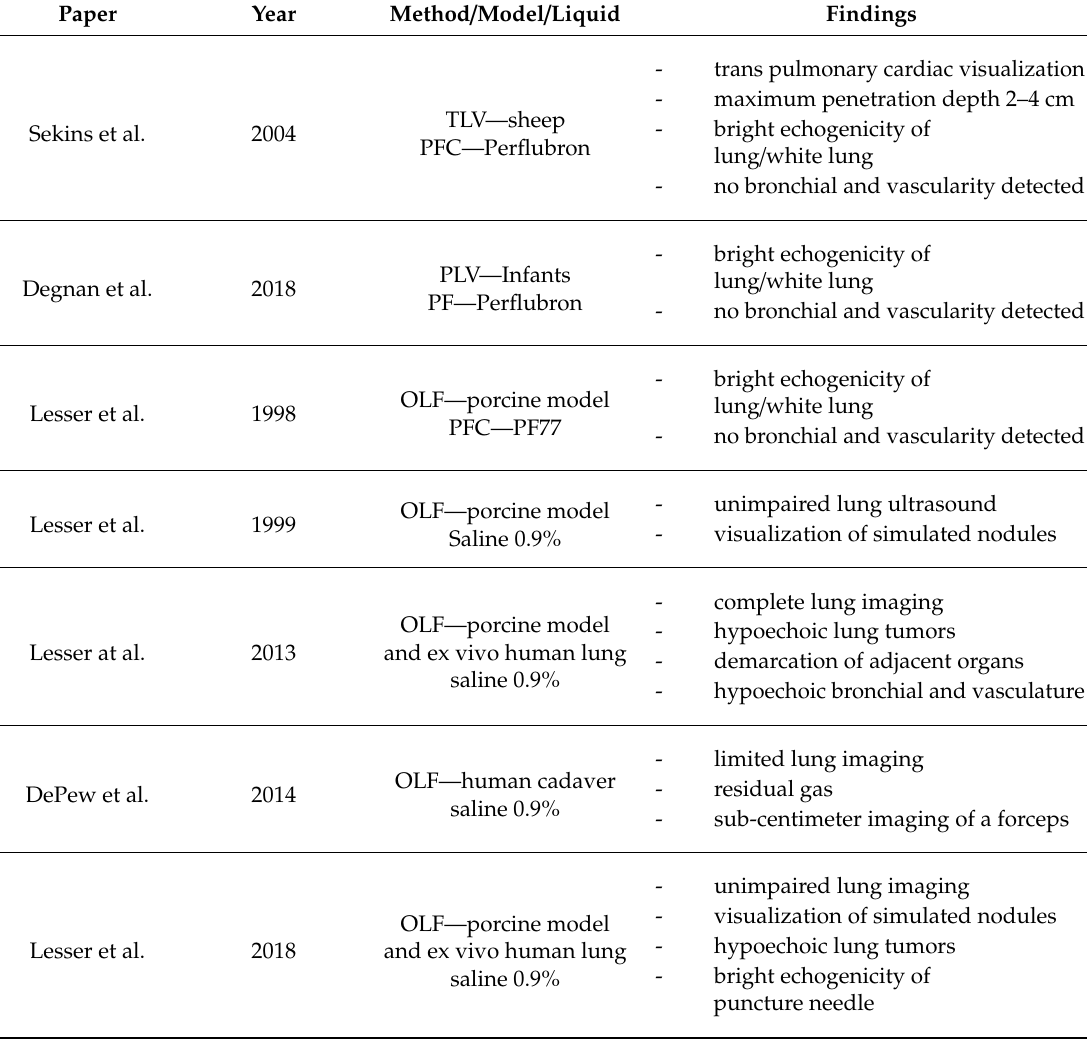
Table 2. Summary of literature related to sonographic imaging of lung during liquid